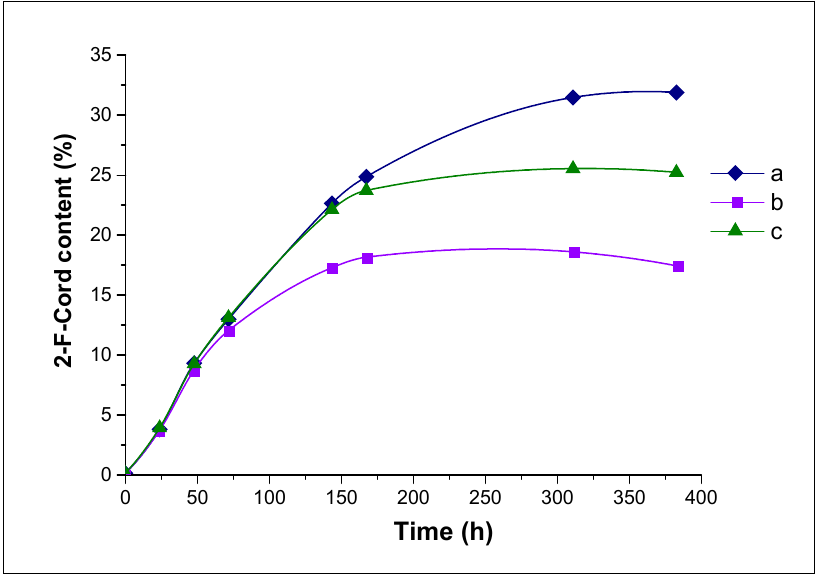
Figure 3. The dynamics of accumulation (HPLC data) of 2-F-Cord 3 in the enzymatic reaction using samples of 3 ′ -dIno 9 obtained by different methods: a - Catalytic dehalogenation (Scheme 1, route B), b - Radical dehalogenation (Scheme 1, route A), c - Mixture of a and b . Reaction conditions: 1 mM 2-F-Ado, 1.5 mM 3 ′ -dIno, 2 mM KH 2 PO 4 , pH 7.0, 50 ° C, 12.5 IU PNP, 1 mL. Epoxide 11 concentration: a —0 mM, b —0.24 mM, c —0.12 mM.